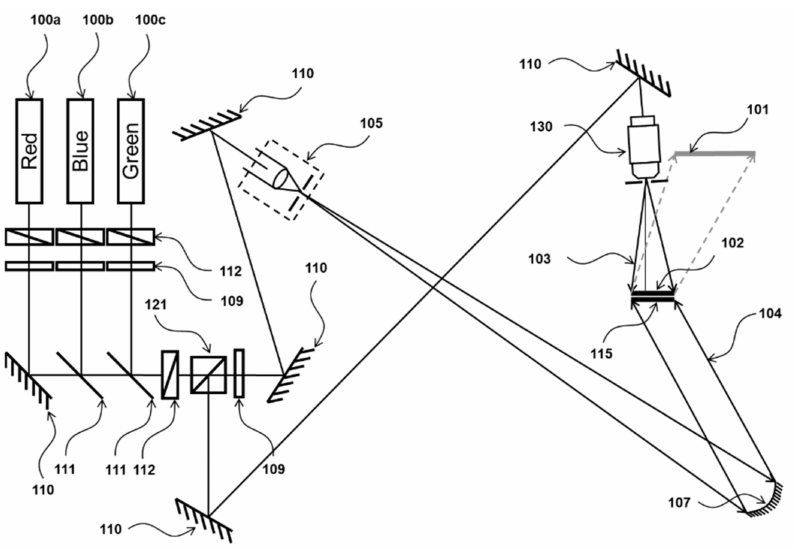
Figure 3. Schematic view of the BS-HOE two-beam close distance copy